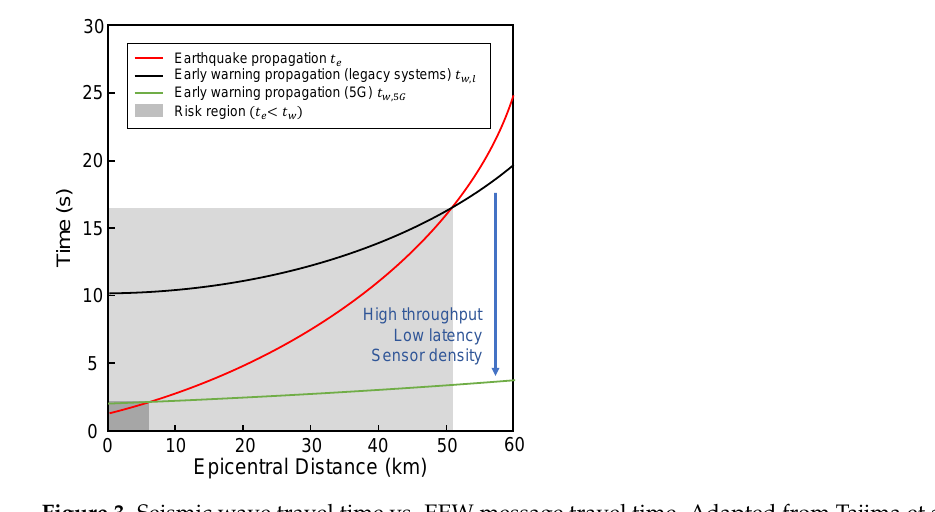
Figure 3. Seismic wave travel time vs. EEW message travel time. Adapted from Tajima et al.